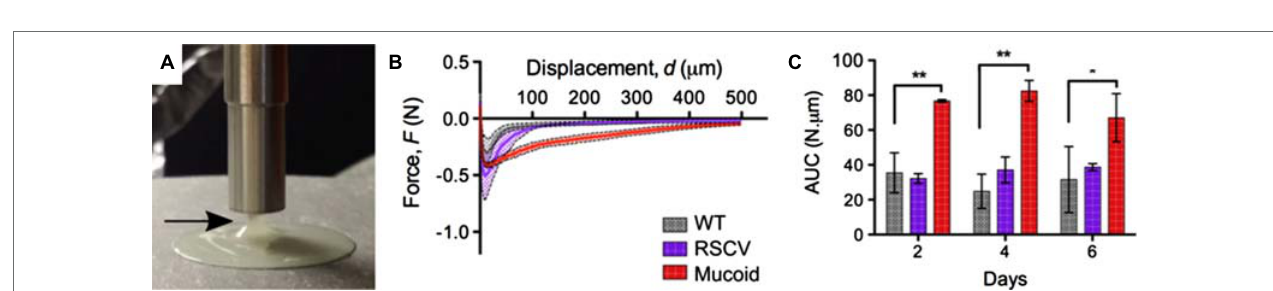
FIGURE 2 | Measurement of biofilm adhesion with a rheometer. (A) Image of a mucoid P. aeruginosa colony biofilm taken as the shaft of the rheometer is pulled away from the biofilm. The arrow indicates the biofilm adhered to the probe as it is raised off the biofilm. (B) Force-displacement curves of 4-day-old P. aeruginosa colony biofilms from the unloading phase of the measurements. RSCV stands for rugose small colony variant. (C) Area under the curve (AUC) as a quantification of biofilm adhesion for 2-day-, 4-day-, and 6-day-old P. aeruginosa colony biofilms from measurements shown in (B) . Data presented as mean ± standard deviation (SD), n = 4. * p < 0.01; ** p < 0.001. This figure is adapted with permission from Gloag et al.